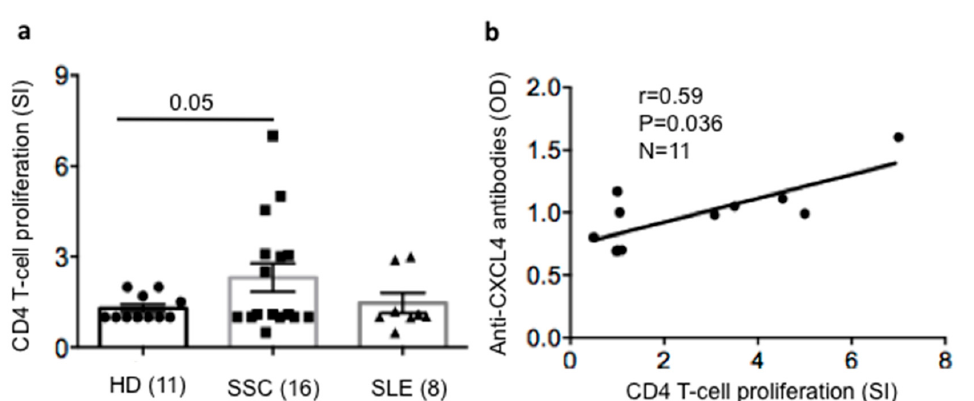
Figure 5. SSc-derived CD4 T-cells can proliferate in response to CXCL4 and their proliferation correlates with the level of anti-CXCL4 antibody reactivity. ( a ) PBMCs from SSc patients (SSC) or HD or SLE patients were either untreated or cultured for five days with 5 µg/mL of CXCL4, and then bromodeoxyuridine (BrdU) incorporation was evaluated in CD3 pos CD4 pos cells. BrdU incorporation was assessed using an anti-BrdU antibody staining by flow cytometry (gating strategy in Figure S1). Methods. Horizontal bars are the means, vertical bars are the standard error of the means, p values by Mann–Whitney test (one-tailed). ( b ) Correlation between T-cell proliferation (reported as SI) and anti-CXCL4 antibody reactivity (OD), by Spearman’s correlation test. Spearman’s “ r ” coefficient, significance p and